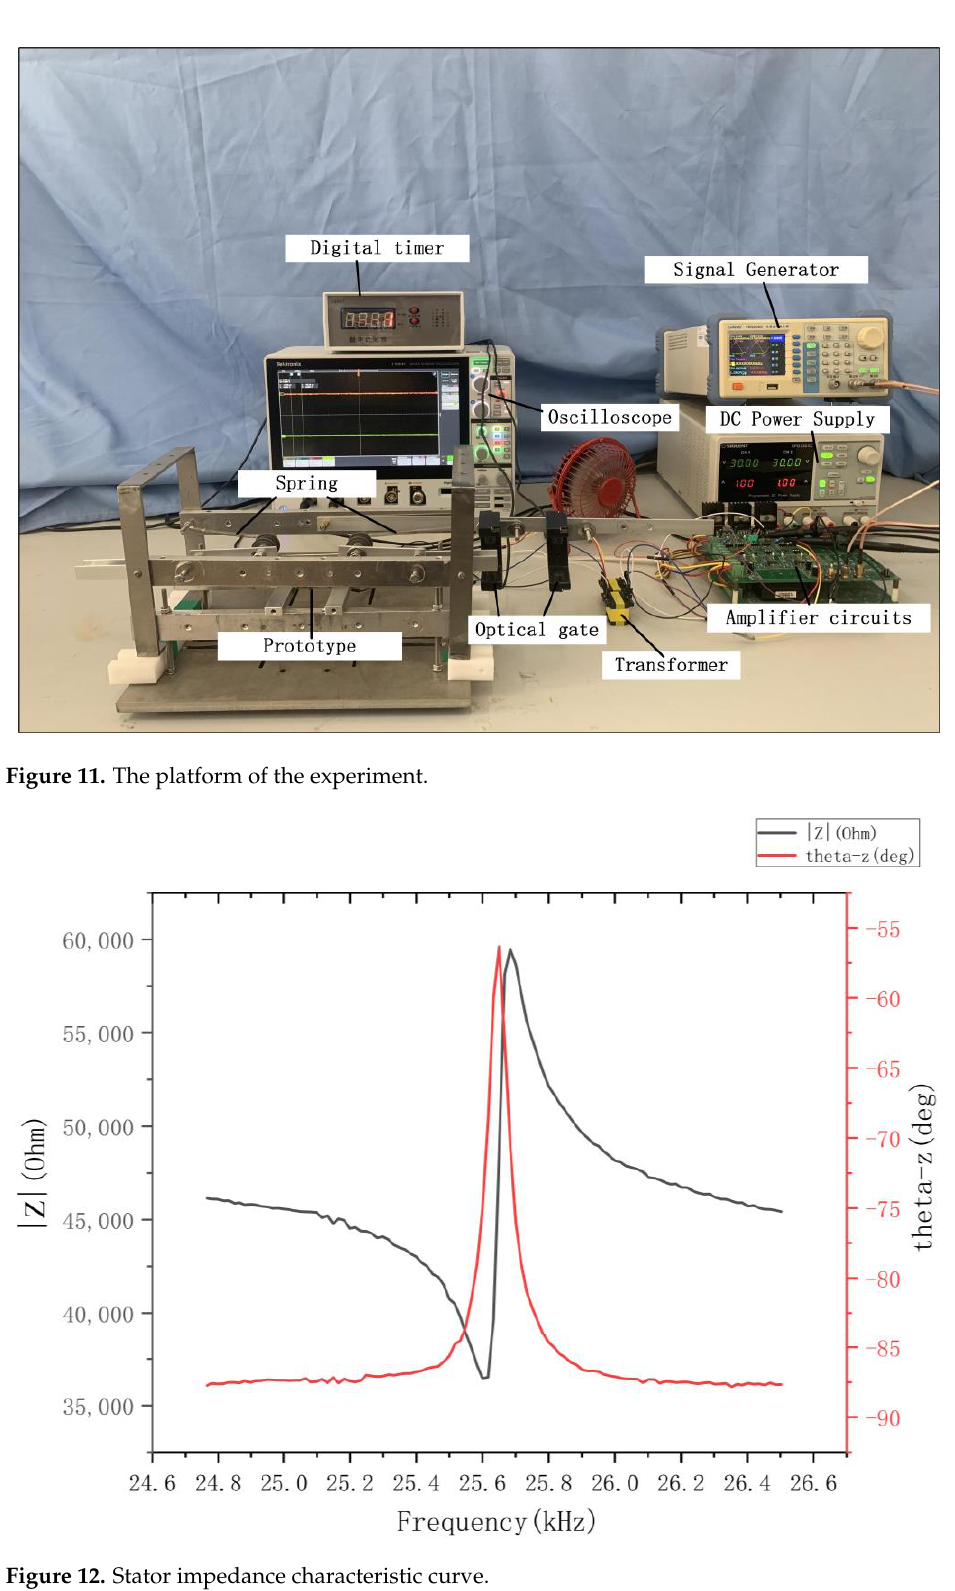
Figure 12. Stator impedance characteristic curve.